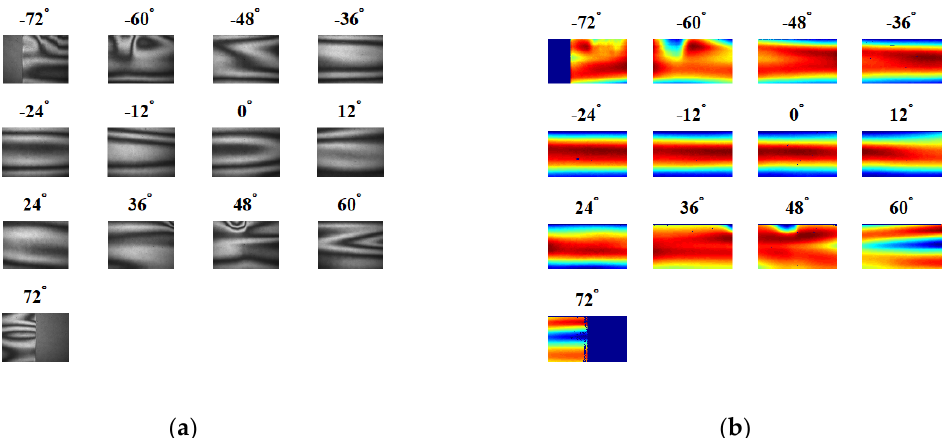
Figure 6. ( a ) Measured interferograms of different sub-apertures, fringe maps of sub-apertures and ( b ) the phase maps of sub-apertures.